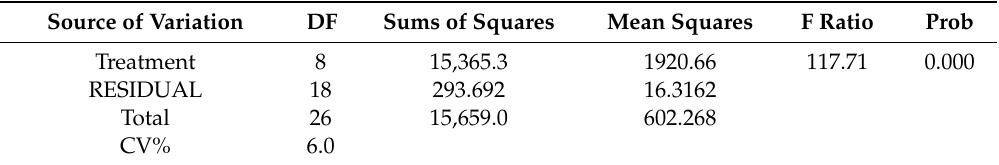
CV%: Coe ffi cient of